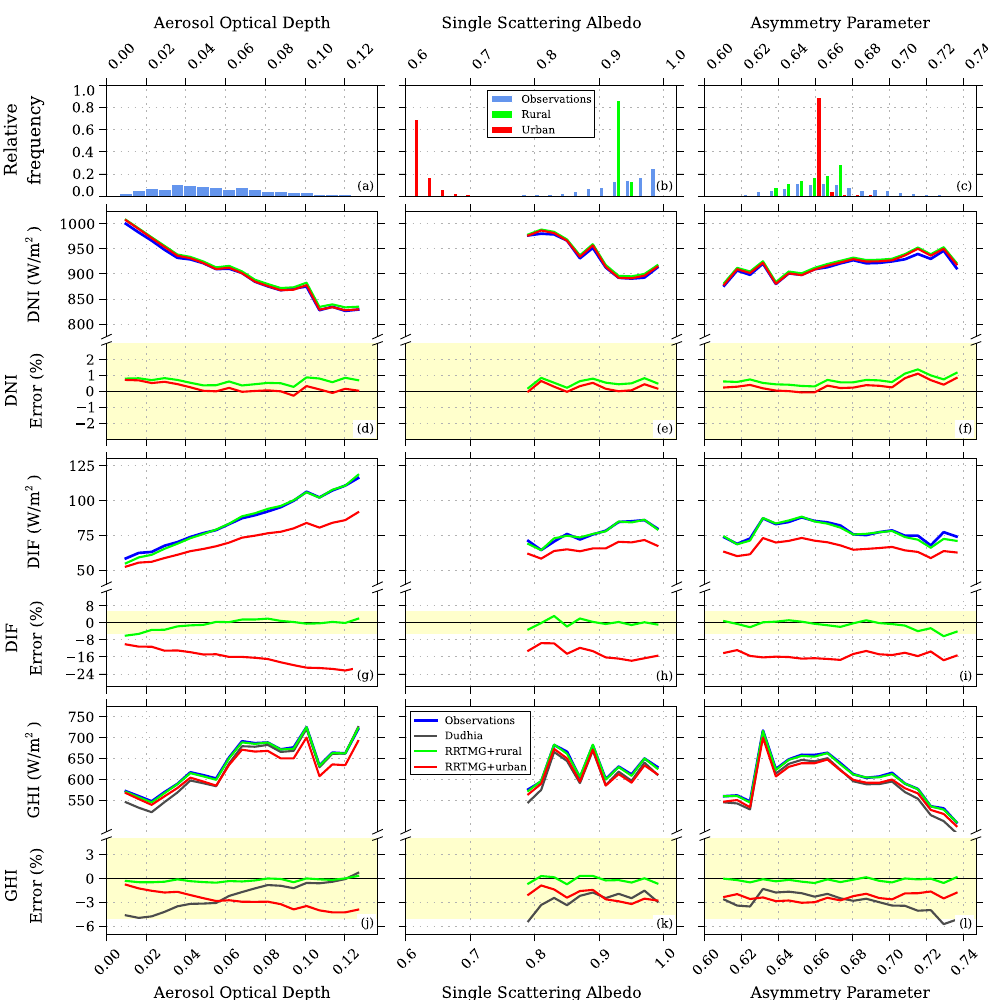
Figure 4. Error analysis with respect to the variability range of AOD, SSA and ASY parameters for GHI, DNI and DIF that results from the 1- year WRF simulations. Panels (a – c) show the relative frequency distribution of the observed AOD at 0.55µm, the observed and parameterized SSA values and the observed and parameterized ASY values, respectively. Panels (d – l) show the observed and simulated DNI, DIF and GHI values (upper half of the panels) as well as their relative errors (lower half of the panels) as a function of the observed AOD at 0.55µm, SSA and ASY values. The expected observational error region for the surface solar irradiance observations, roughly estimated as ± 5 %, is highlighted in